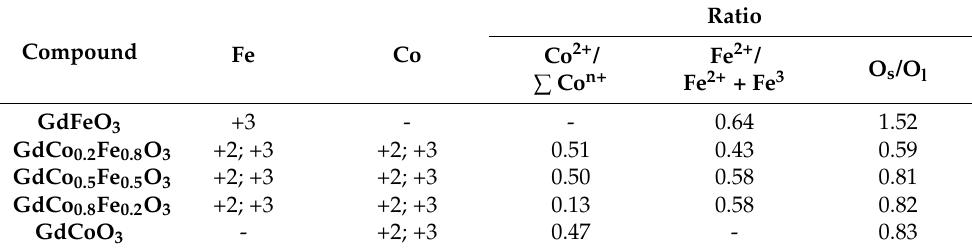
Table 2. Results of studying the surface composition and state of atoms by XPS [33].